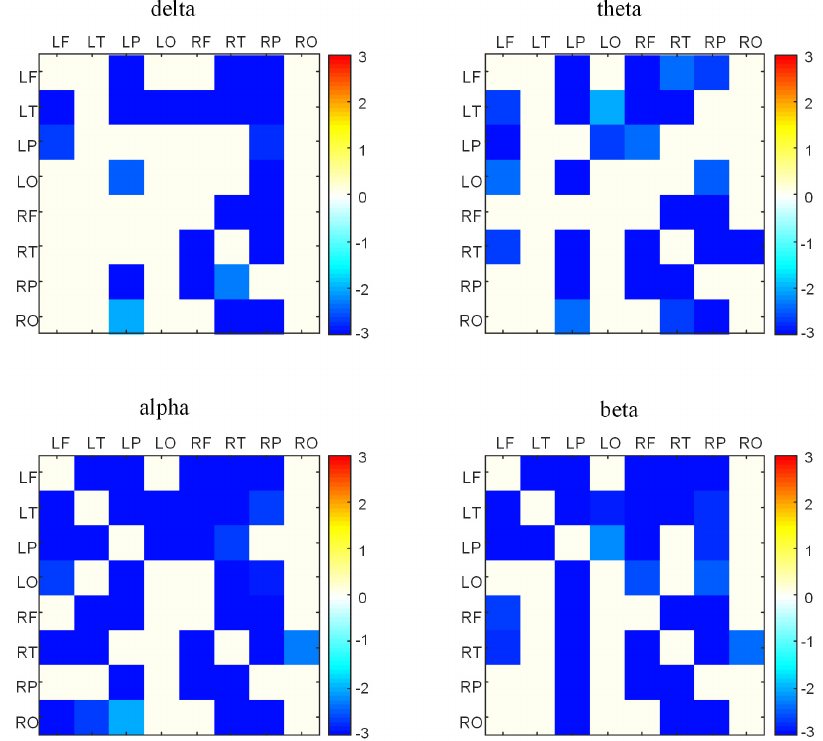
Figure 4. The statistical comparison of effective connectivity in transhemispheric brain regions between autism spectrum disorder (ASD) and typically developing (TD) groups. The color bar denotes the t value after FDR correction.